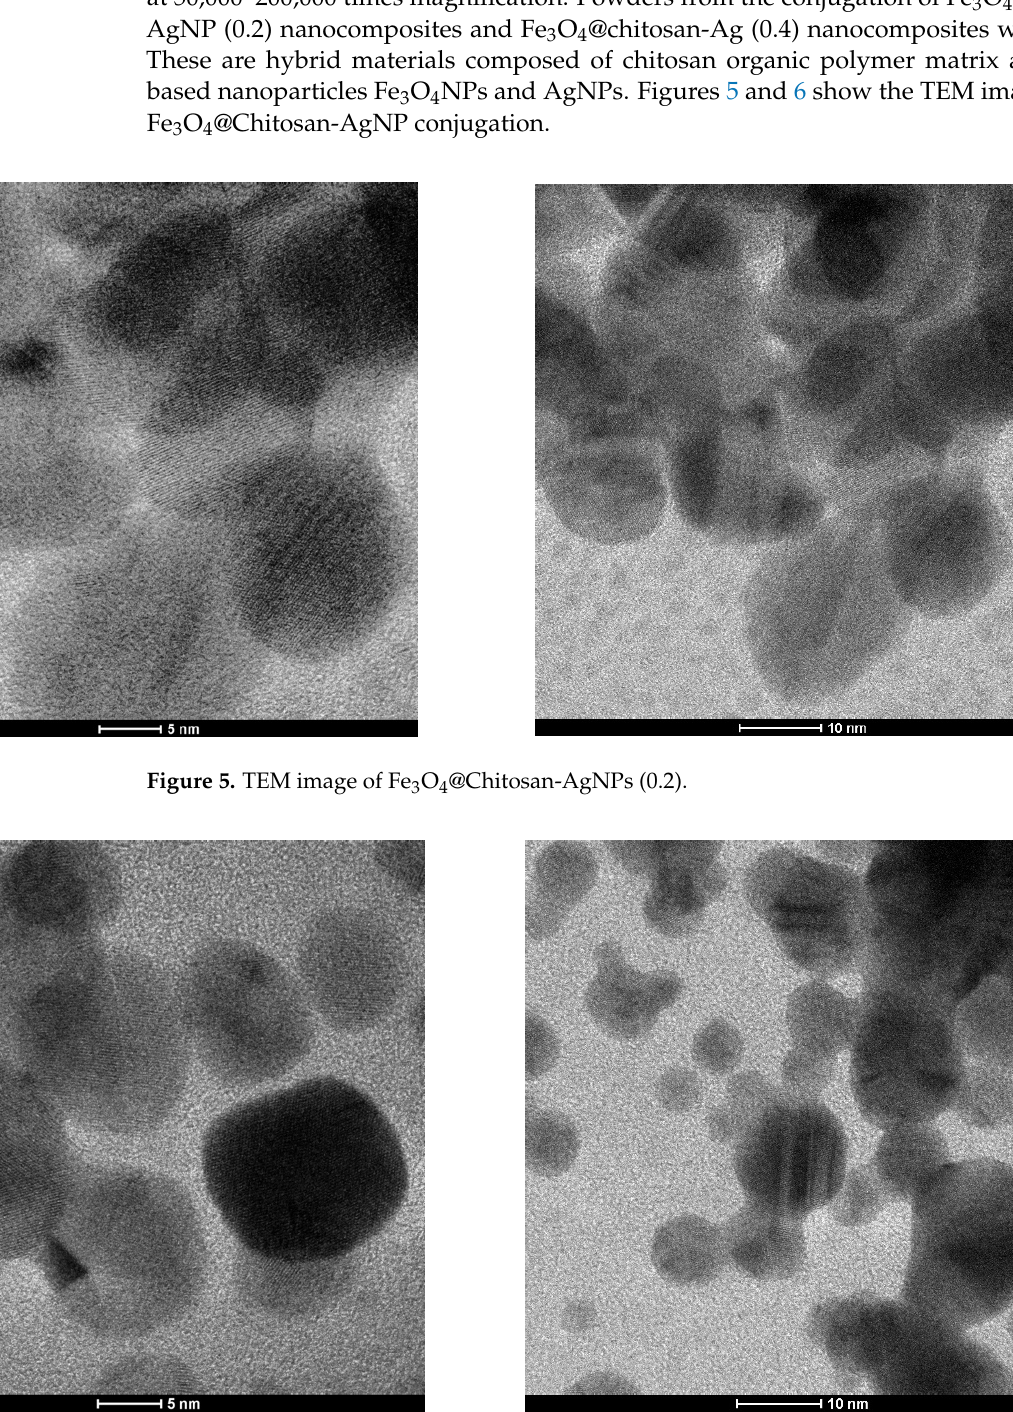
Figure 4. UV-visible spectra of Fe 3 O 4 @Chitosan-AgNP nanocomposites.